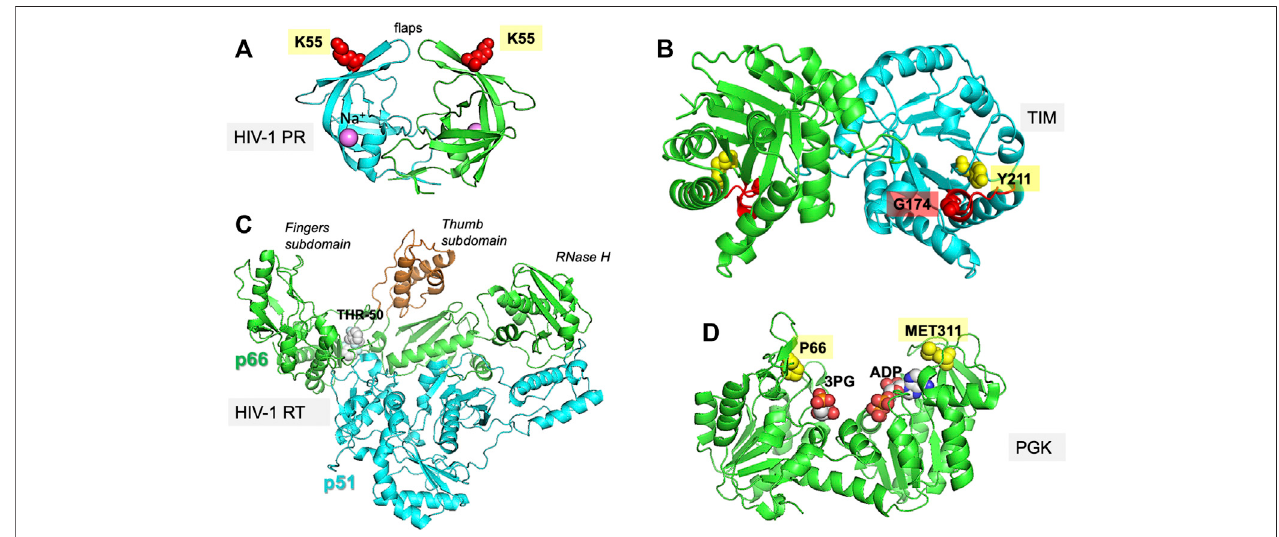
FIGURE1| Proteinsinvestigatedinthepresentstudy.The fi guredisplaystheexperimentallyresolvedX-raystructuresalsousedasinitialstructuresforsimulations. (A) HIV-1 protease (PR) (PDB id: 1tw7) is a wide-open, apo structure. The residue K55 on each subunit of the homodimer isused to probe the opening/closure of the fl aps. (B) TIM (PDB id:1tcd) is a homodimeric enzyme, for which the catalytic loop is shown in red on both subunits of the apo state. The distance between the catalytic loop tip residue G174 and Y211 de fi nes loop opening/closure motion in each subunit. (C) HIV-1 RT (PDB id: 2b6a) is a heterodimer composed of p51 and p66 subunits. The current structure is in complex with THR-50. The distance between the fi ngers and thumb subdomains, both located on the p66 subunit, indicate a transition between closed and open conformations of the region between these two subdomains. (D) PGK (PDB id: 2xe7) in the presence of the two substrates, 1,3- bisphosphoglycerate (bPG) and ADP. The distance between P66 and M311, two residues located at the tips of the N- and C-domains near the ligands, probes the opening/closing movement of the enzyme required for its catalytic activity.